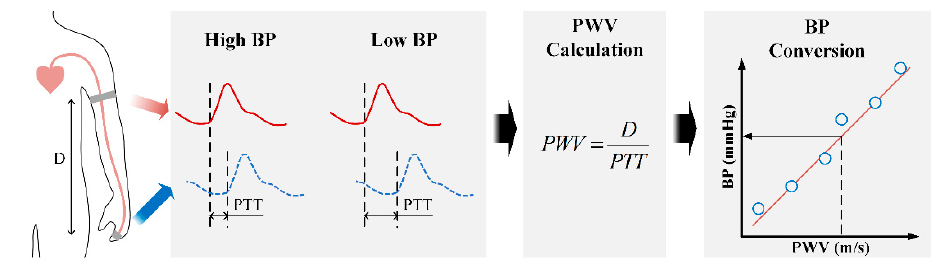
Figure 1. Methodology of pulse wave velocity (PWV)-based blood pressure (BP) estimation.